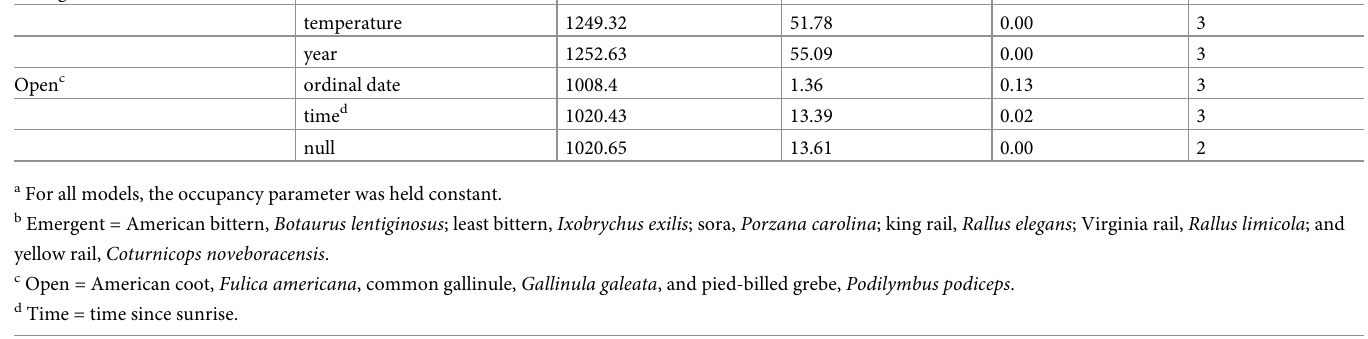
a For all models, the occupancy parameter was held constant. b